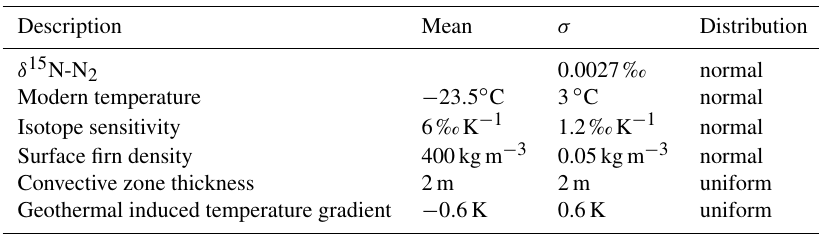
Table C1. Model Parameters used for steady-state Herron–Langway